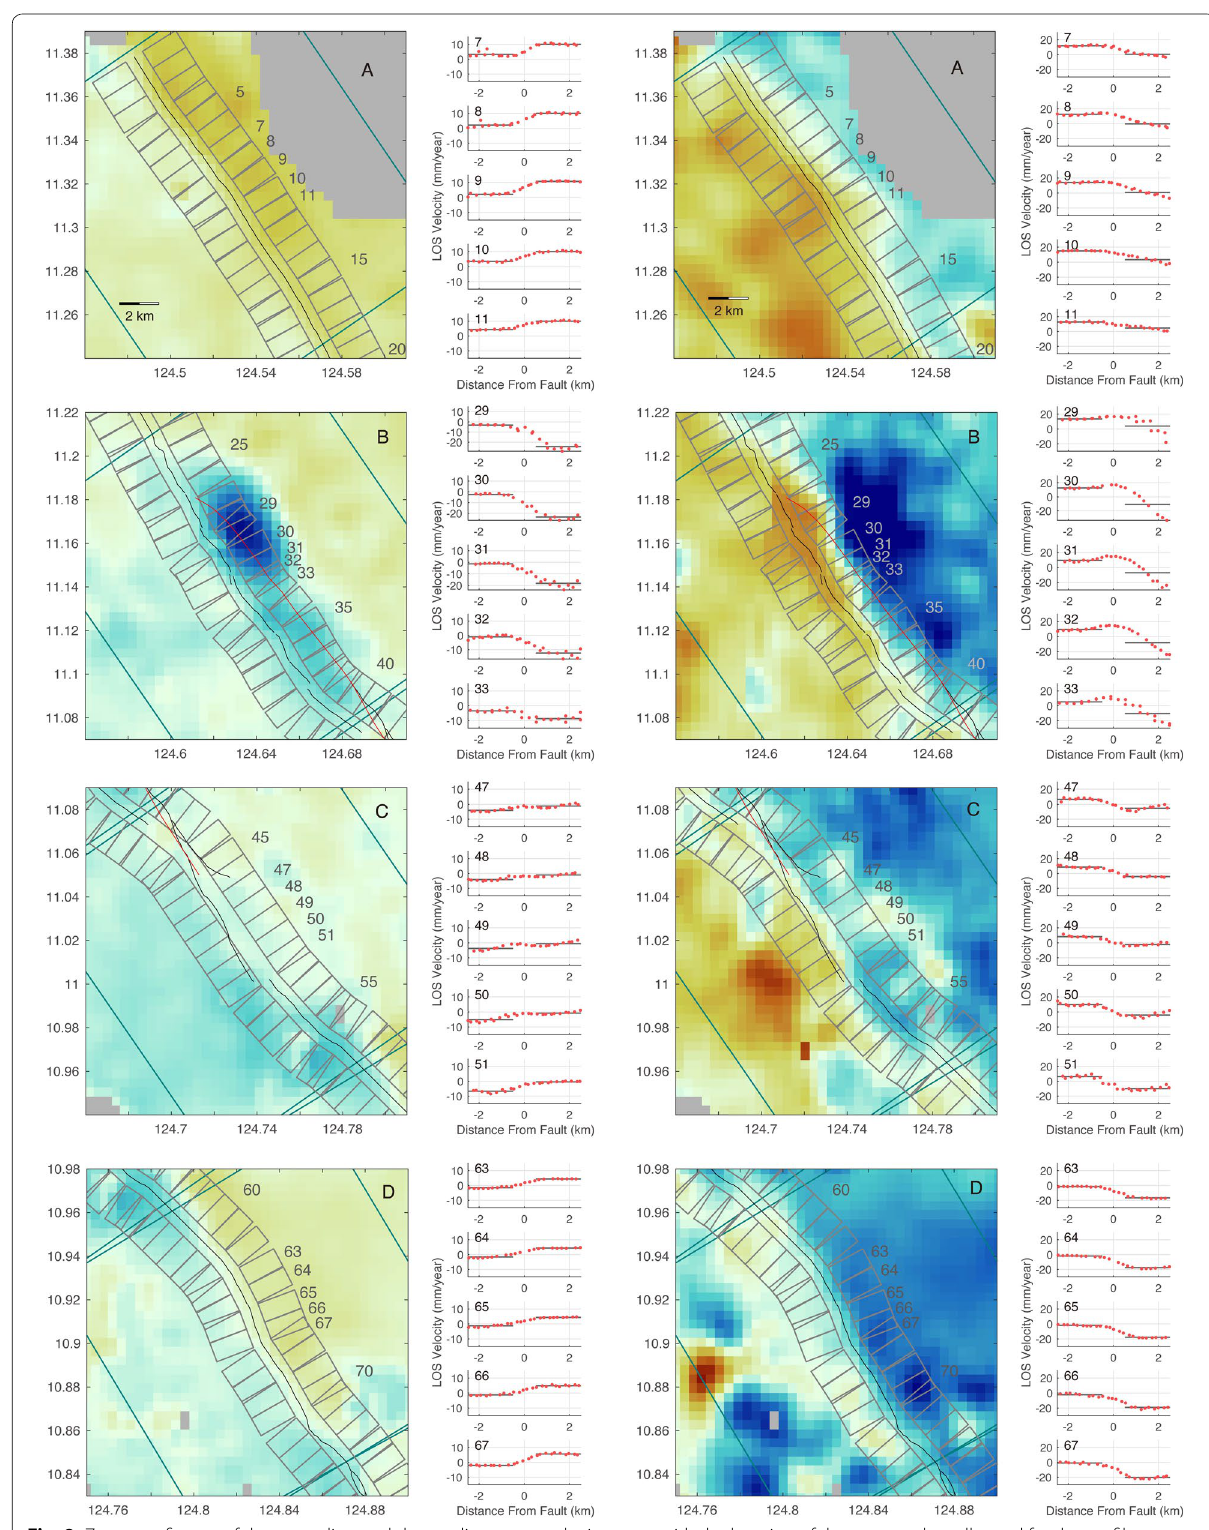
Fig. 8 Zoom-up figures of the ascending and descending mean velocity maps with the location of the rectangular cells used for the profile analysis, and selected velocity profiles. The location of the cells were numbered starting from north (1) to south (138). In the velocity profile figures, the velocity values within the cells are plotted, as well as the average velocity on each side of the fault denoted in black